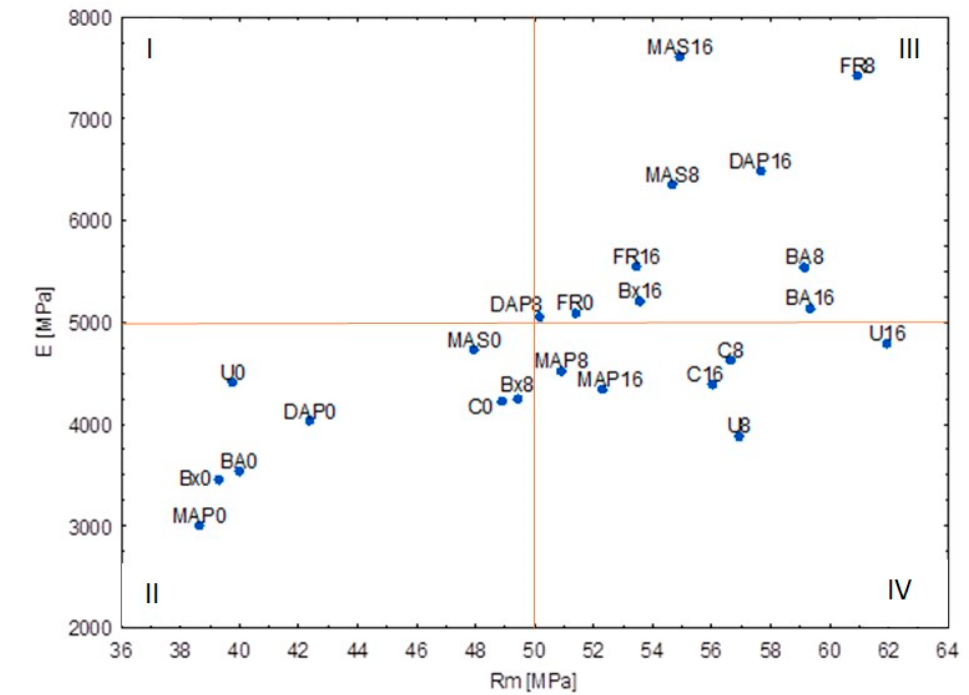
Figure 3. Illustration of the Rm and E relationship of aging cycles and chemical compounds. I–IV are sections of graph.